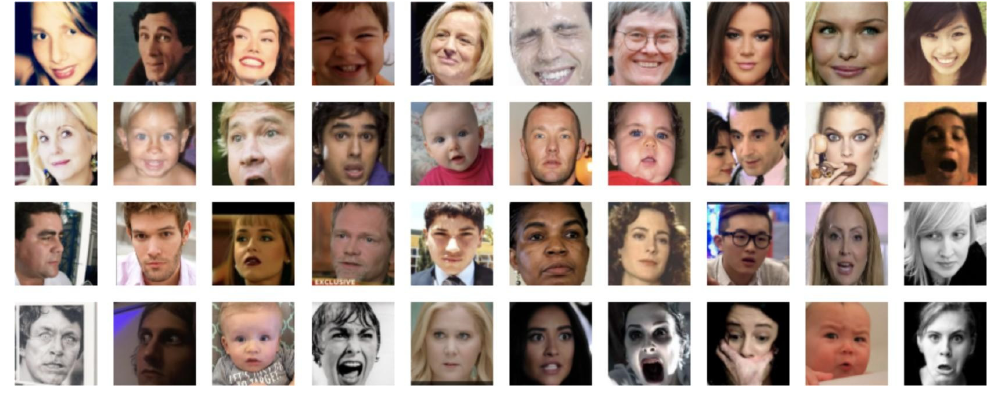
Figure 5. Samples from the AffectNet dataset.